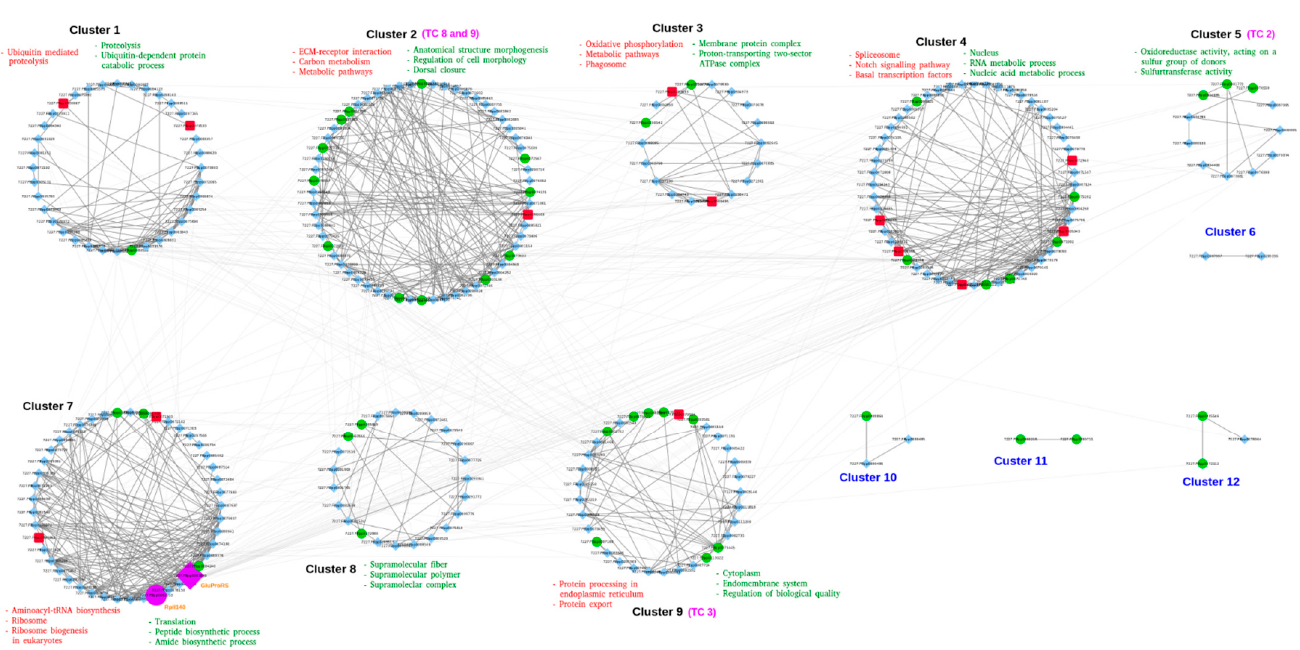
Figure 5. Community analysis of the interaction network. Red, green, and cyan nodes represent up- (square), downregulated (circle), and STRING-predicted (diamonds) genes, respectively. Nodes in purple indicate the hub genes labeled with orange text. The topmost enriched KEGG pathways (red text), GO terms (green text), and transporter class (pink text) are mentioned for each cluster. Clusters with <10 nodes (blue text) were excluded from the analysis.